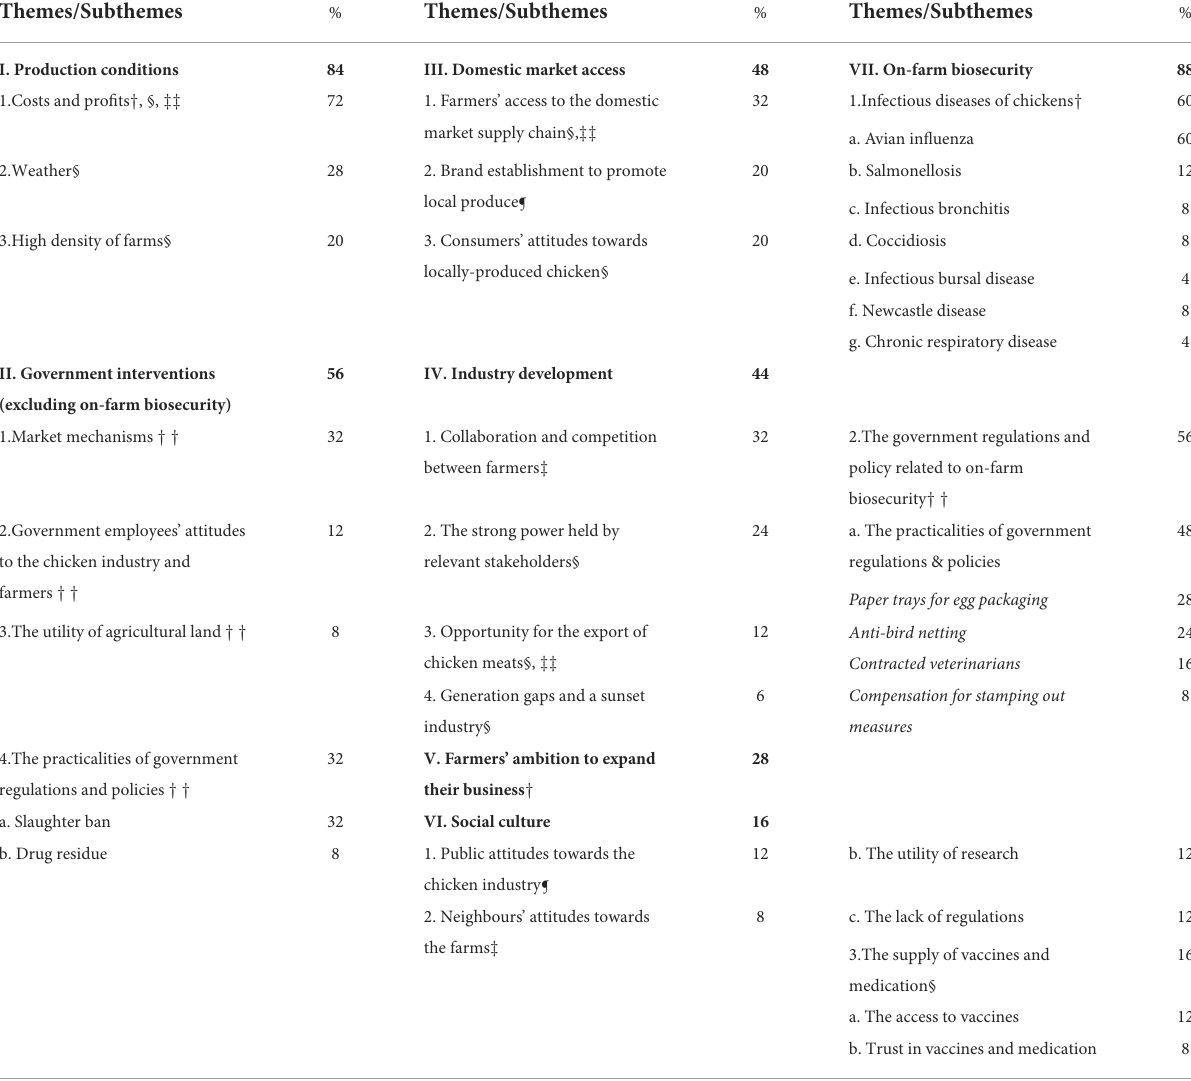
TABLE 2 Summary of themes emerging from the interview data [by percentage (%) of participants who addressed them].